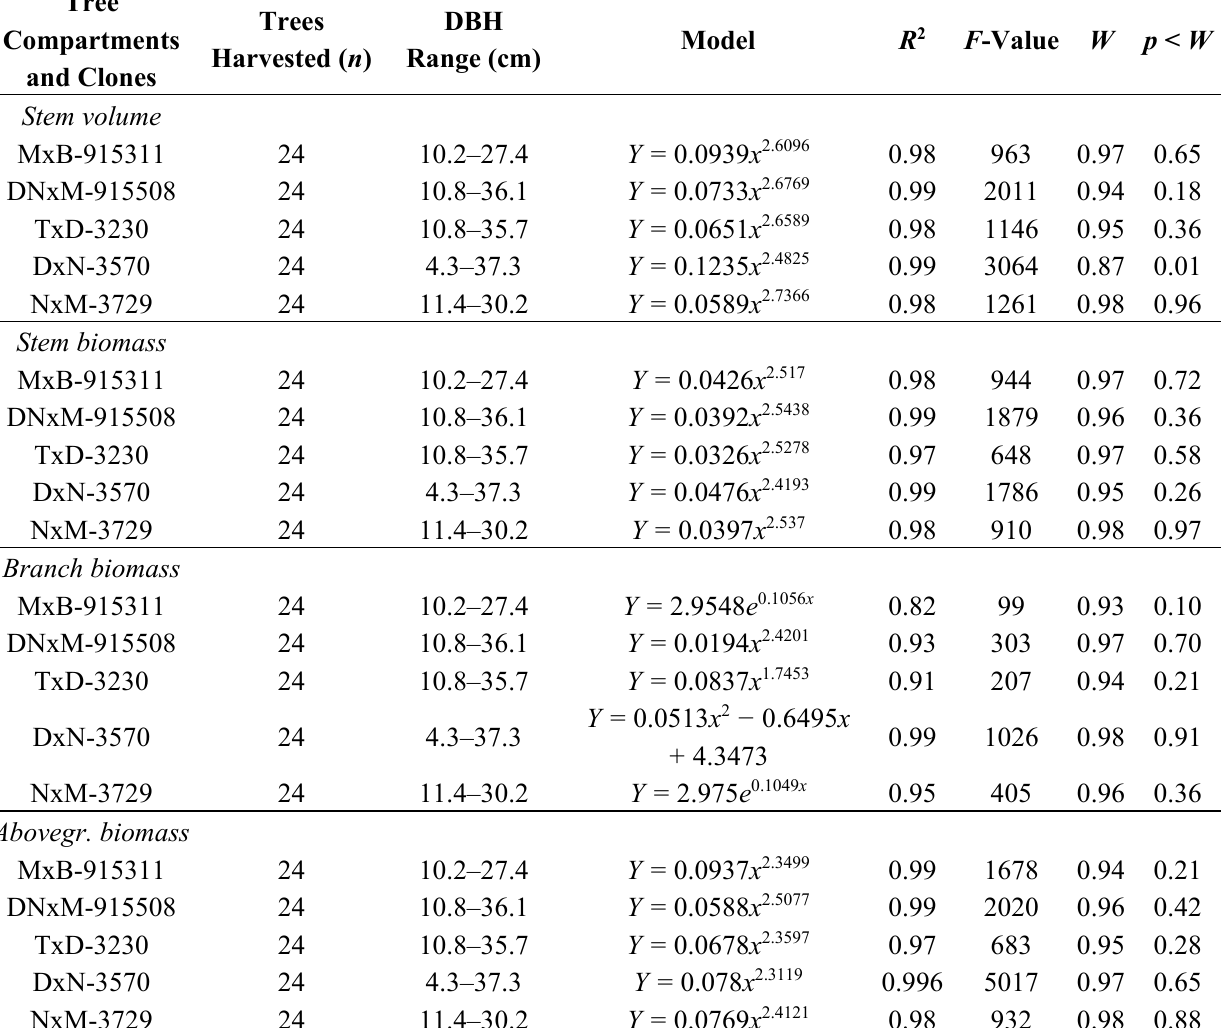
Table 2. Clone specific allometric relationships between diameter at breast height (cm), as the predictor variable ( x ), and stem volume (dm 3 ), stem dry biomass (kg), branch dry biomass (kg), and woody aboveground dry biomass as the response variables ( Y ). For each model, goodness of fit expressed by the Shapiro-Wilk statistic ( W ) is presented with its associated p